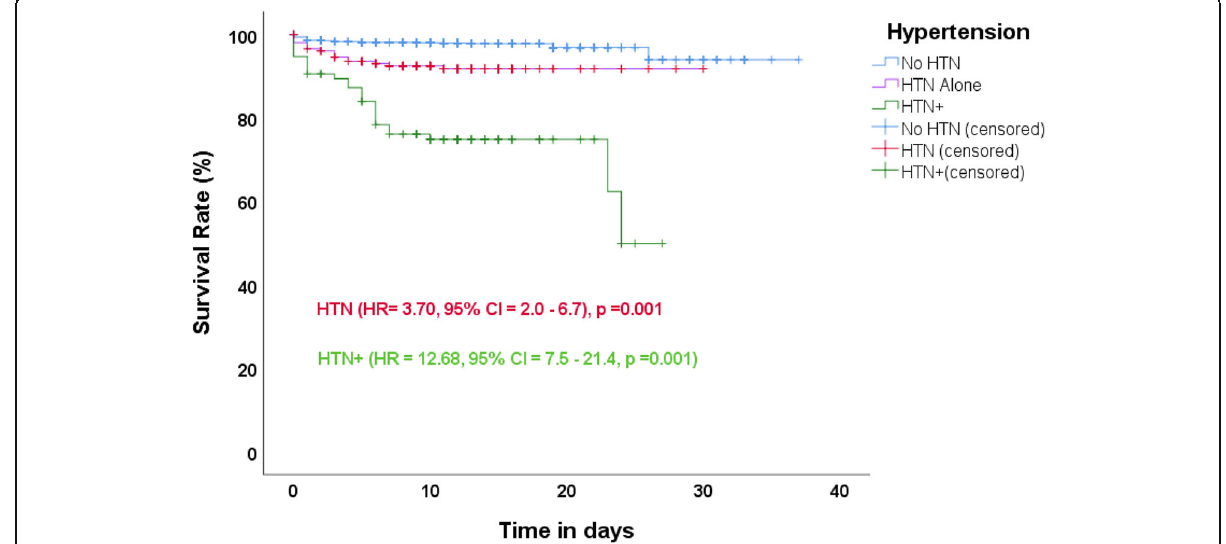
Fig. 1 Kaplan – Meier survival curves for mortality among COVID-19 patients with and without hypertension or with additional